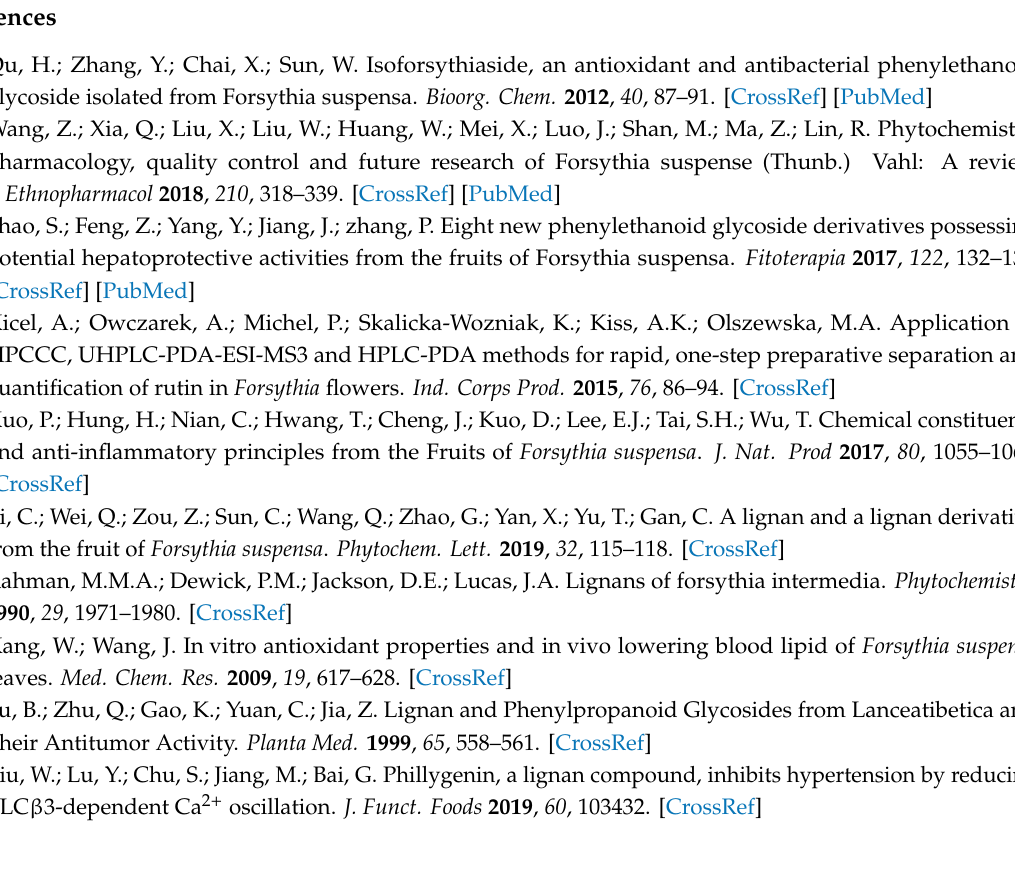
Figure S1: HPLC chromatagrams of specificity (A: Reference substance solution; B: Sample solution; C: Blank solution), Figure S2: Di ff usion results of di ff erent dyes (left: water-soluble dye; right: oil-soluble